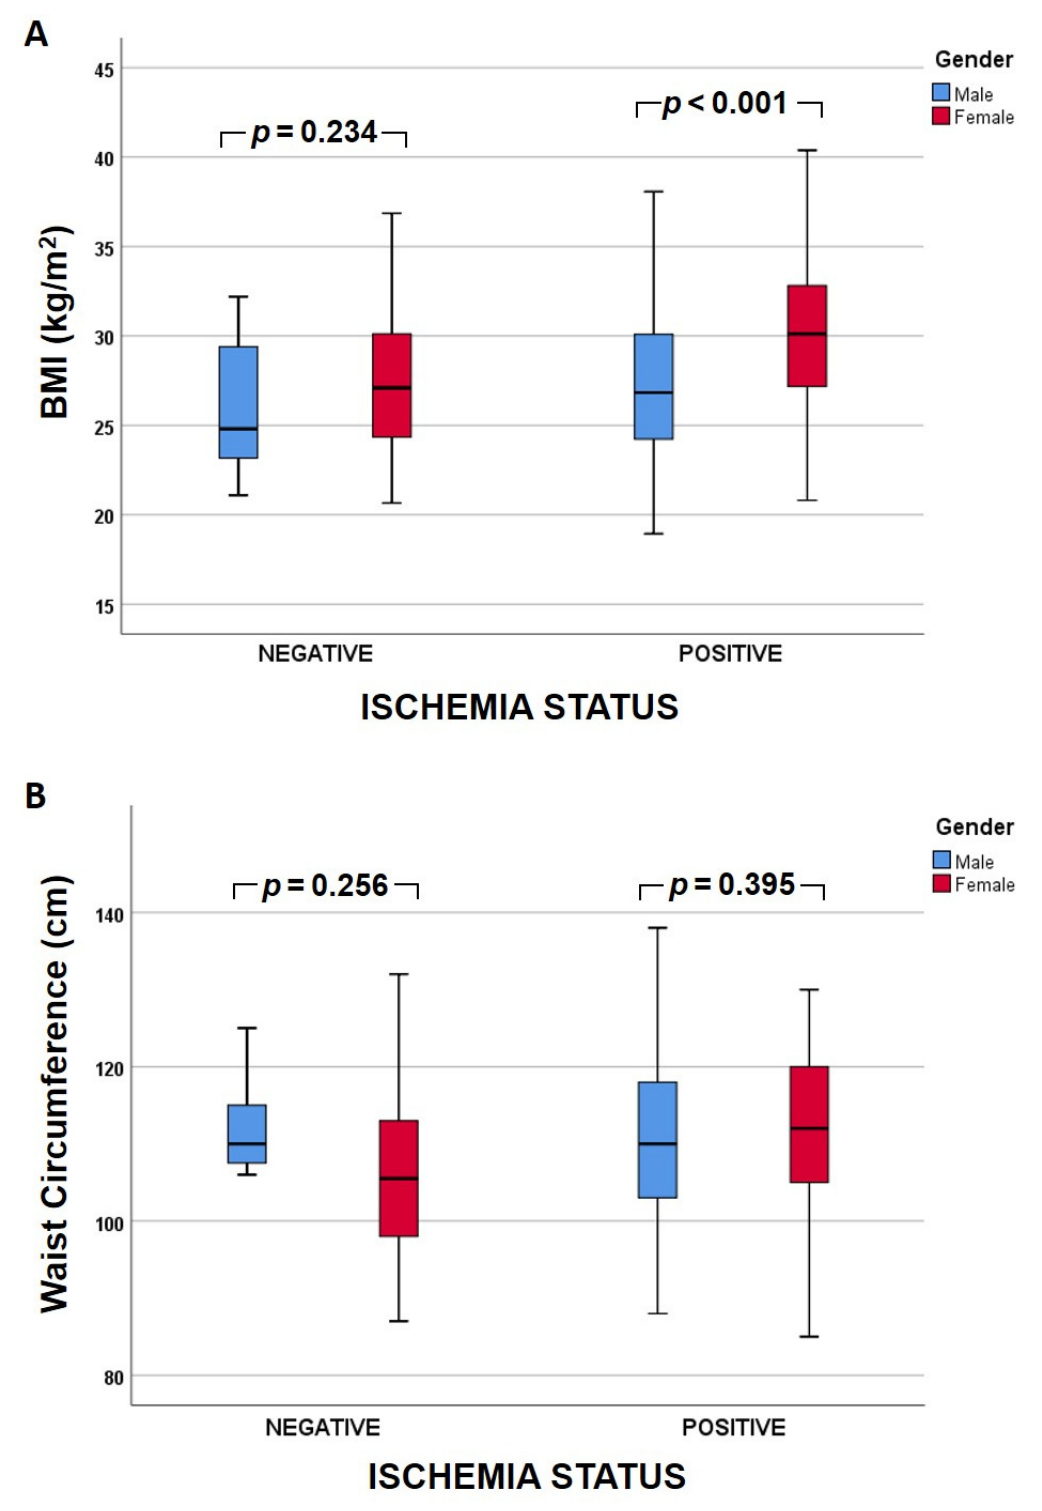
Figure 1. Clustered box plot of ( A ) body mass index (BMI) and ( B ) waist circumference between males and females according to ischemia status (primary grouping). Each box plot shows the median (bold line), the 25th and 75th quartile (lower and upper box border, respectively), and the minimum and maximum values